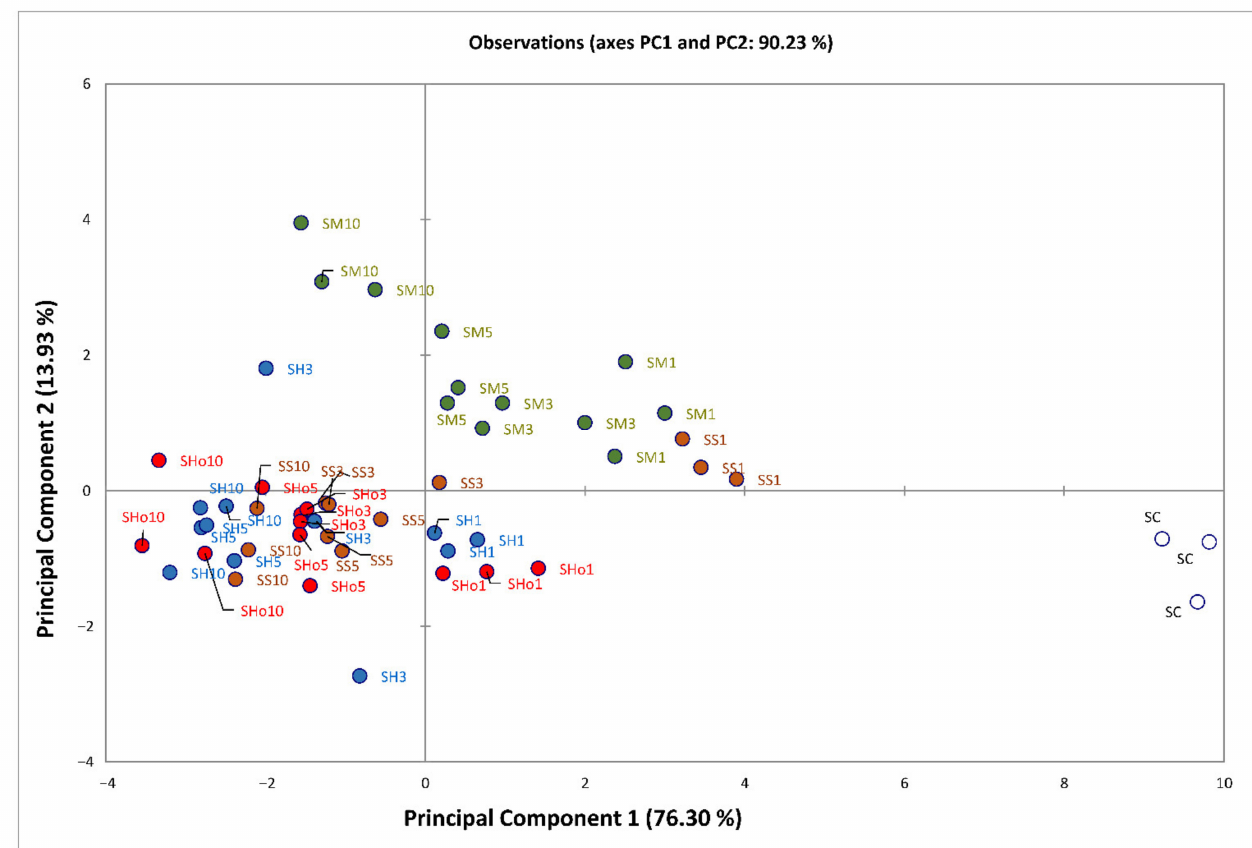
Figure 2. Colour evaluation of biscuits using PCA. SC, control biscuit; SHo, biscuit with added grape seed flour (0, 3, 5, or 10%); SM, biscuit with added mint (0, 3, 5, or 10%); SH, biscuit with added clove (0, 3, 5, or 10%); and SS, biscuit with added cinnamon (0, 3, 5, or